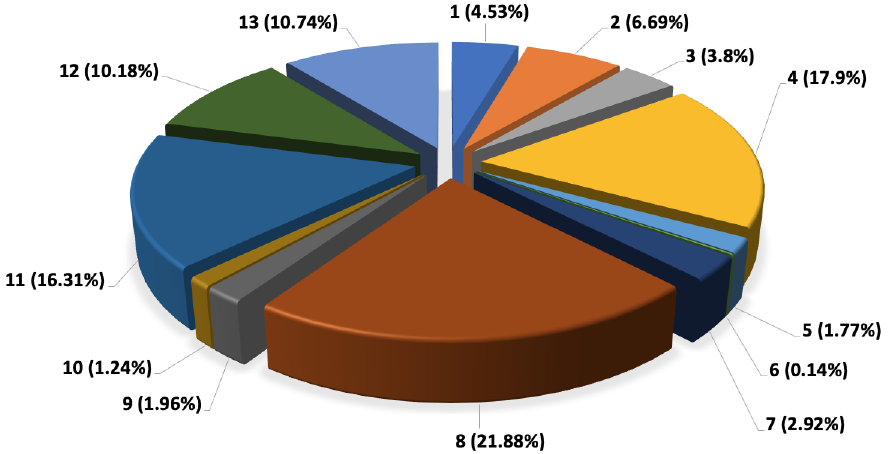
Figure 15. CO 2 cumulative emission percentage per